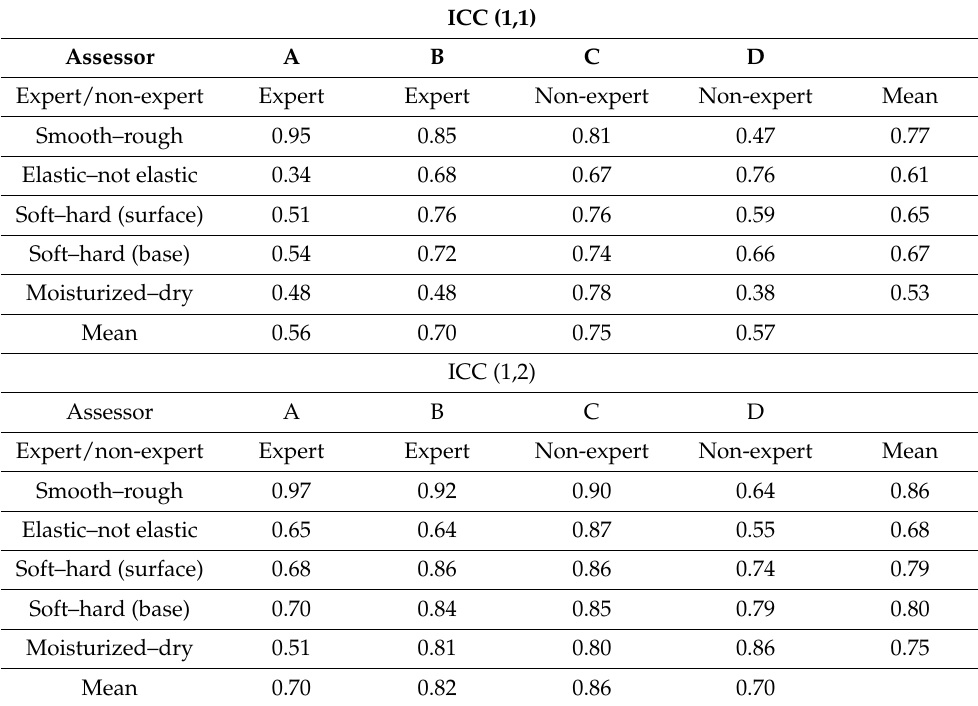
Table 8. Intraclass correlation coefficient (ICC) (1,1) and ICC (1,2)